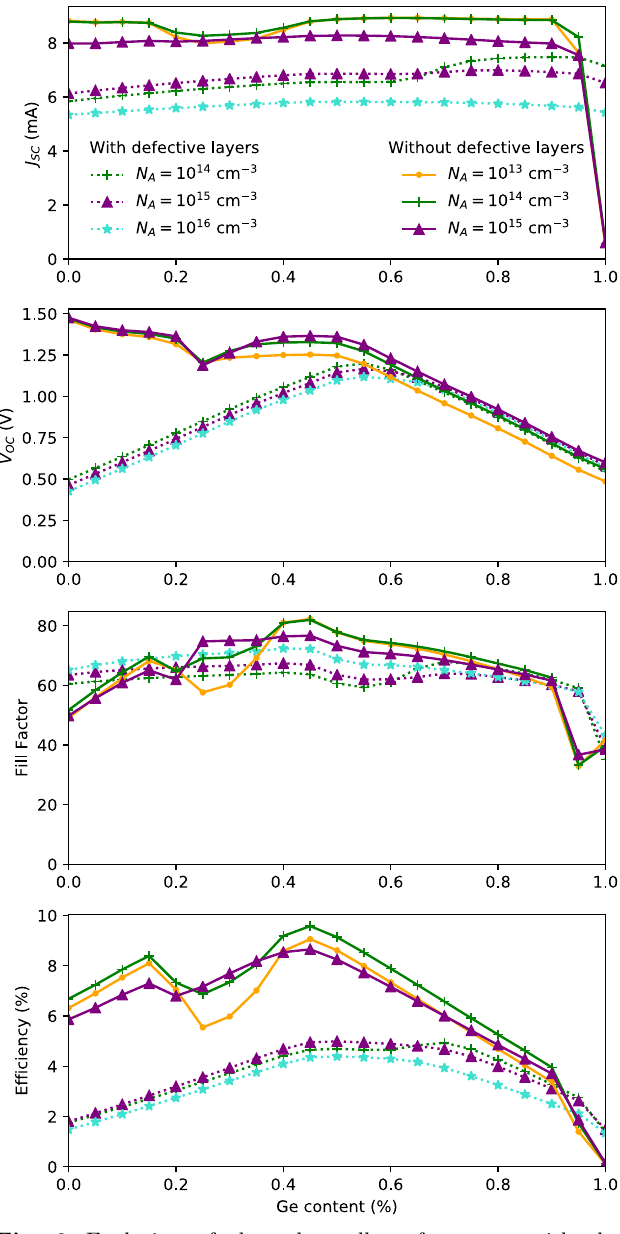
Fig. 8. Evolution of the solar cell performances with the germanium composition x of the ZnGeO buffer layer for different absorber doping concentration N A using an absorber layer thickness of 2 m m and hole and electron mobilities of 25 cm 2 V (cid:1) 1 s (cid:1) 1 and 50 cm 2 V (cid:1) 1 s (cid:1) 1 respectively. Simulation are done using interface anddefective layers at the heterojunction(dashedlines) as described in Section 1 and with an ideal heterojunction without such interface and defect layers (plain